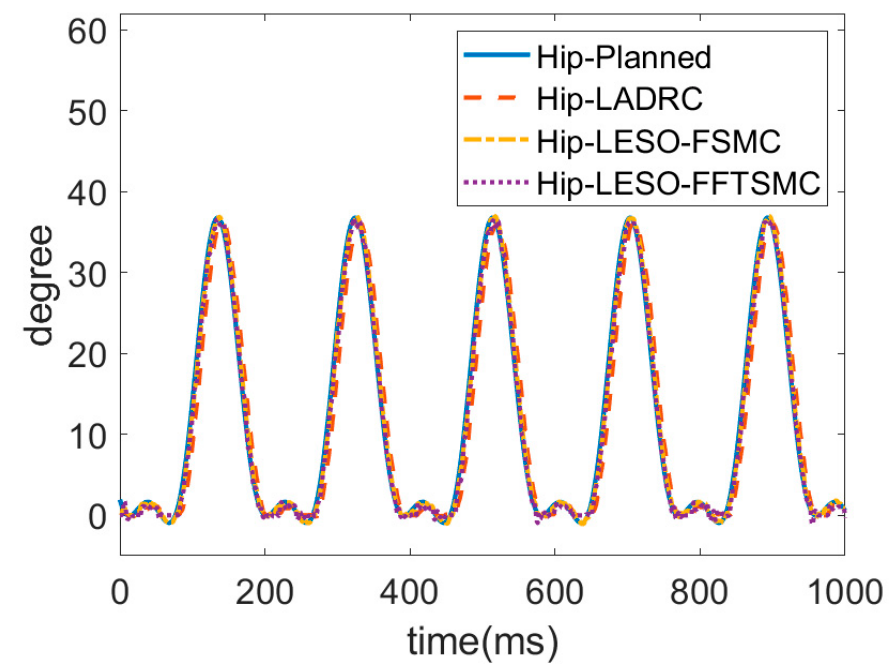
Figure 8. Trajectories of hip joint for proposed LESO-based controllers.